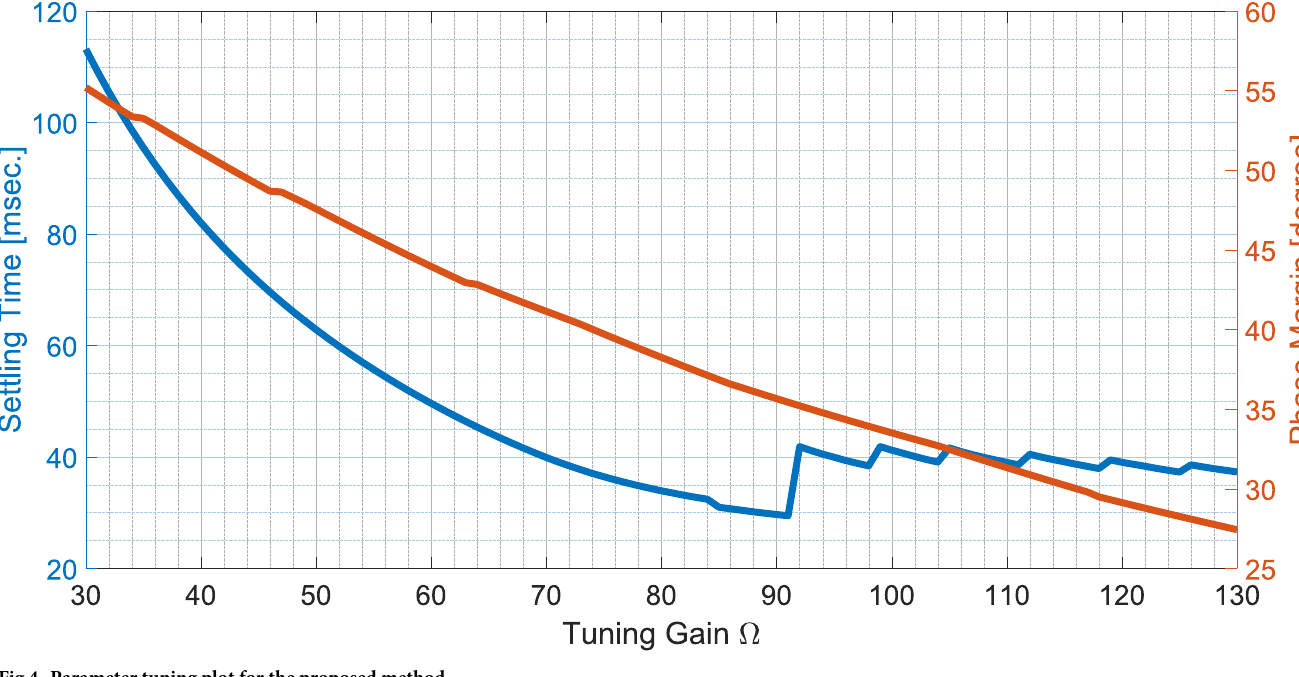
Fig 4. Parameter tuning plot for the proposed method.